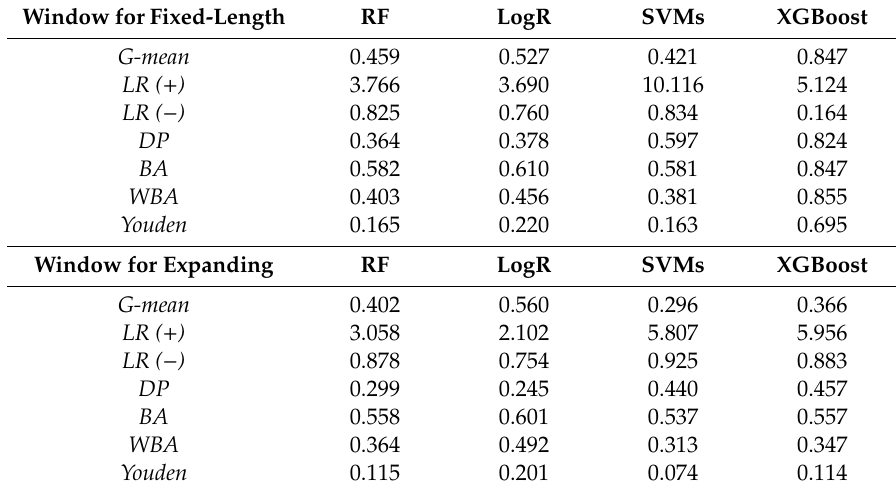
Table 5. Model validation measures of daily data for